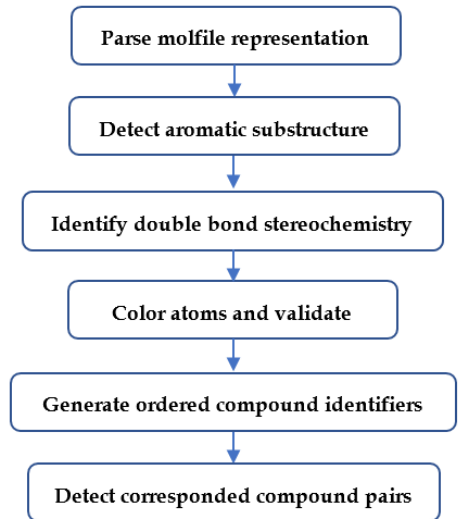
Figure 11. Overview of major compound harmonization steps.